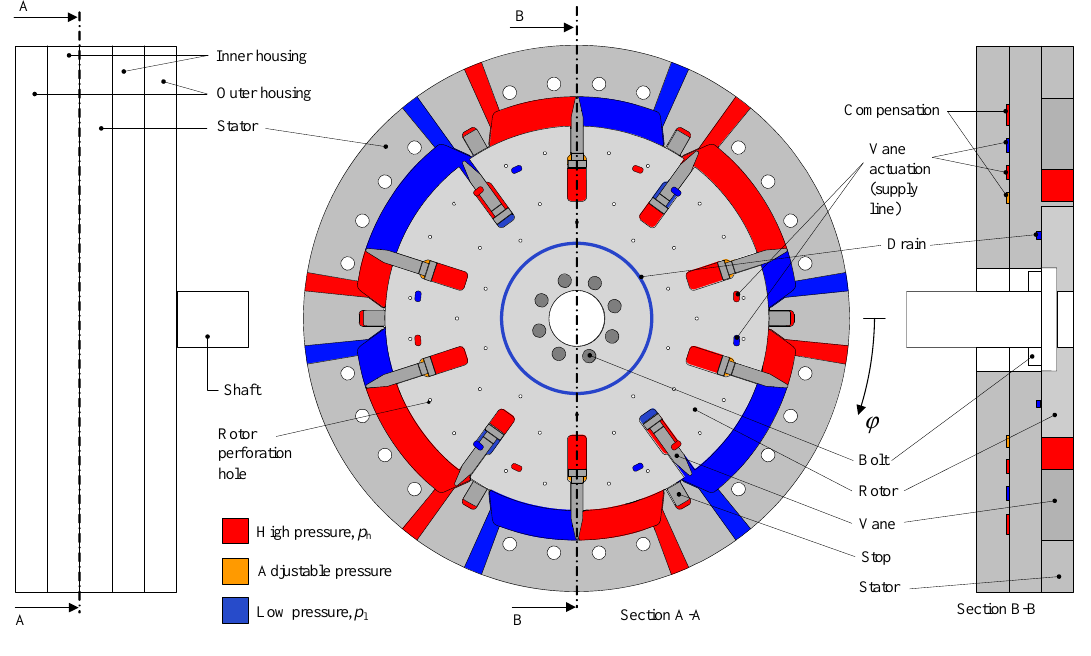
Figure 1: The motor